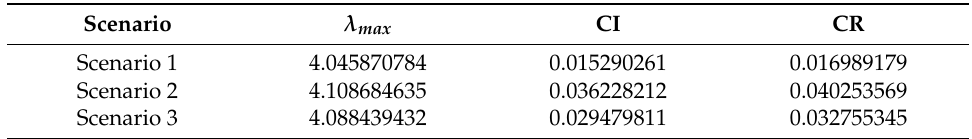
Table 7. Higher Eigenvalue ( λ max ), Consistency Index (CI) and Random Consistency Index (CR) values for the Criteria of the